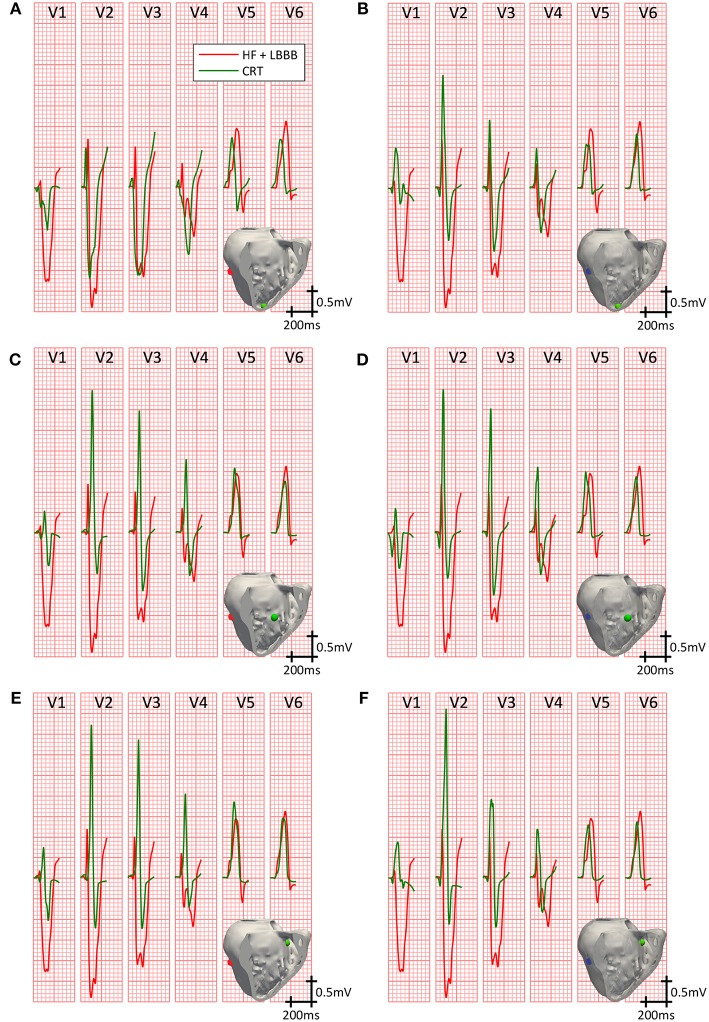
Precordial leads signals on CRT. QRS complexes in the precordial leads under HF + LBBB conditions, before (red trace) and after (green trace) the application of the best CRT configurations (shorter QRSd). Three different locations for the RV pacing lead were tested: RV apex with epicardial (A) and endocardial (B) LV lead stimulation; RV mid septum with epicardial (C) and endocardial (D) LV lead stimulation; and RV upper septum with epicardial (E) and endocardial (F) LV lead stimulation. Stimulation points are shown in light green inside the insets for the RV lead, and in blue and red for the LV endocardial and epicardial lead, respectively.